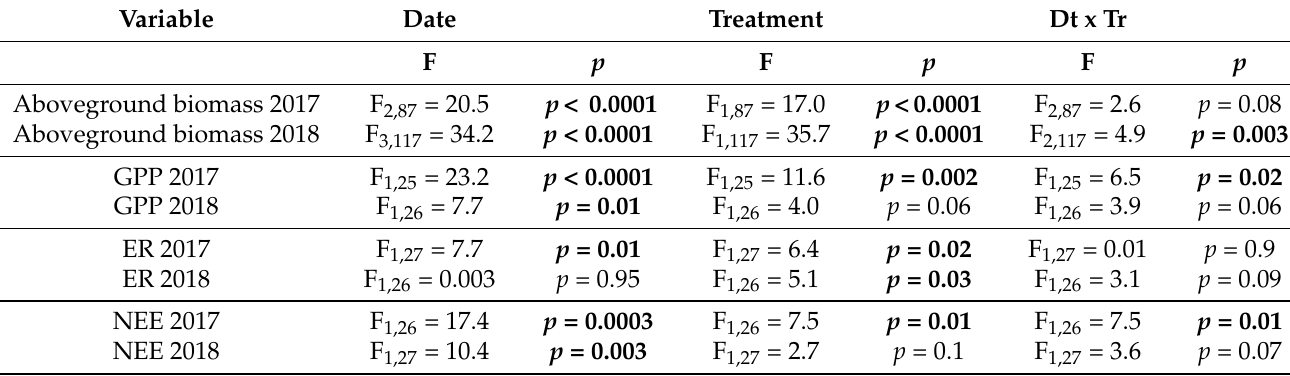
Table 1. Results of analysis of variance examining the effect of date (May, June, July, August or summer, fall) and grazing treatment (caged, uncaged) on aboveground biomass, gross primary productivity (GPP), ecosystem respiration (ER) and net ecosystem exchange (NEE) measured in 2017 and 2018. Significant p -values are